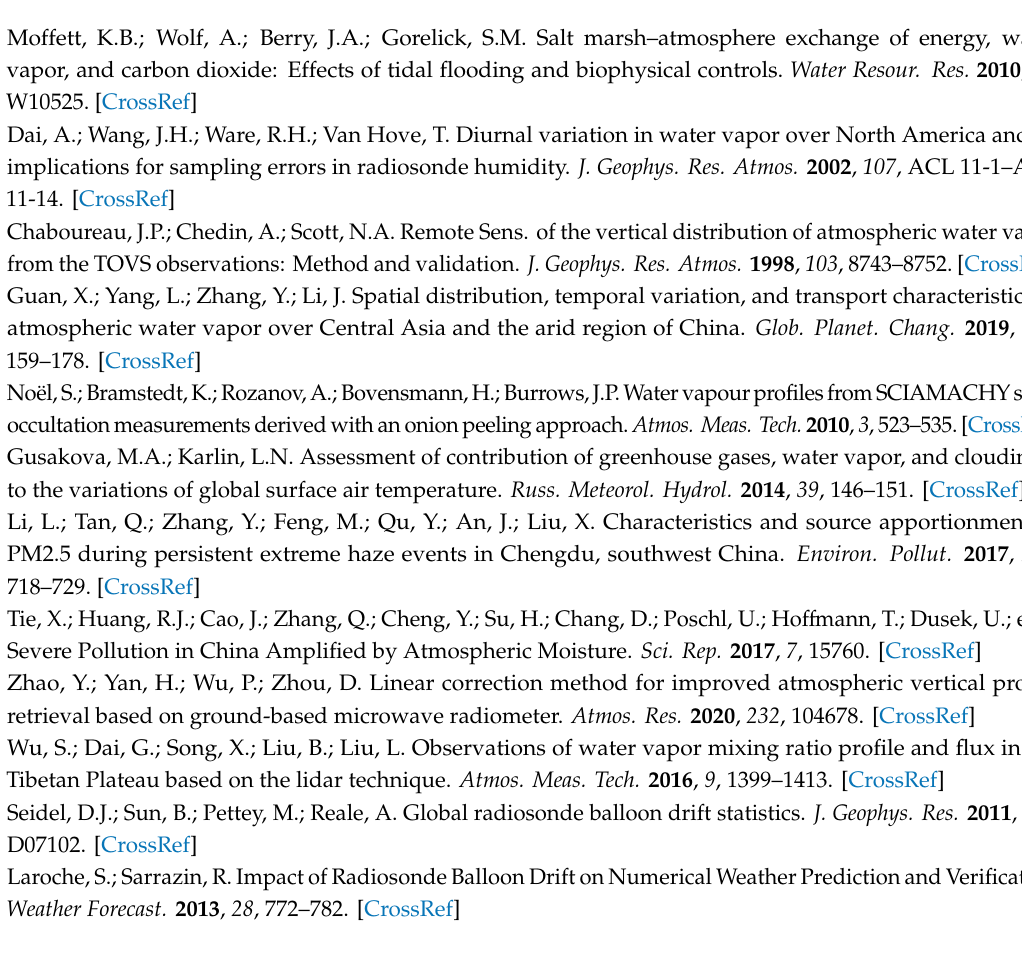
Figure S4: The normalized frequency distribution of DOFs and Chi-square in retrieved results; Figure S5: The